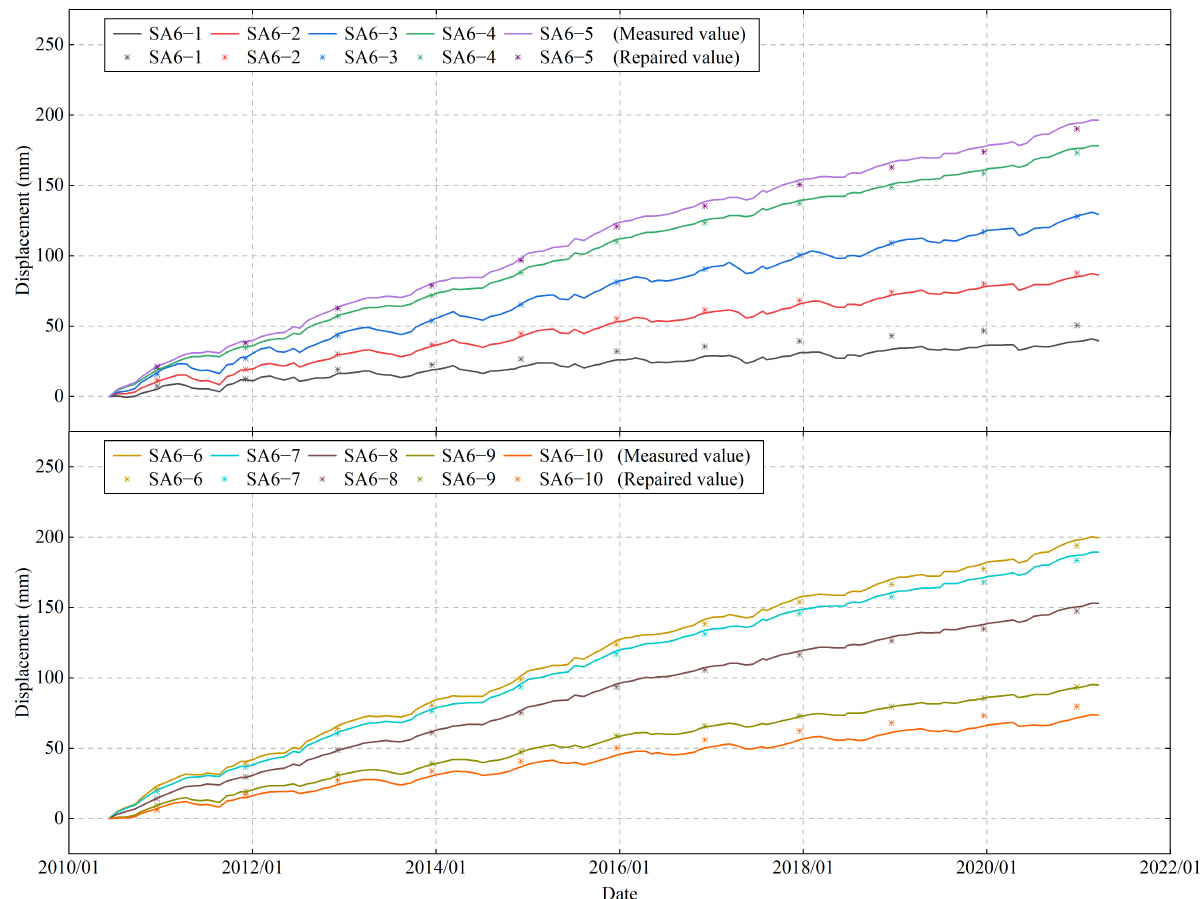
Figure 4. Comparison between measured value and repaired value of vertical deformation measuring points.